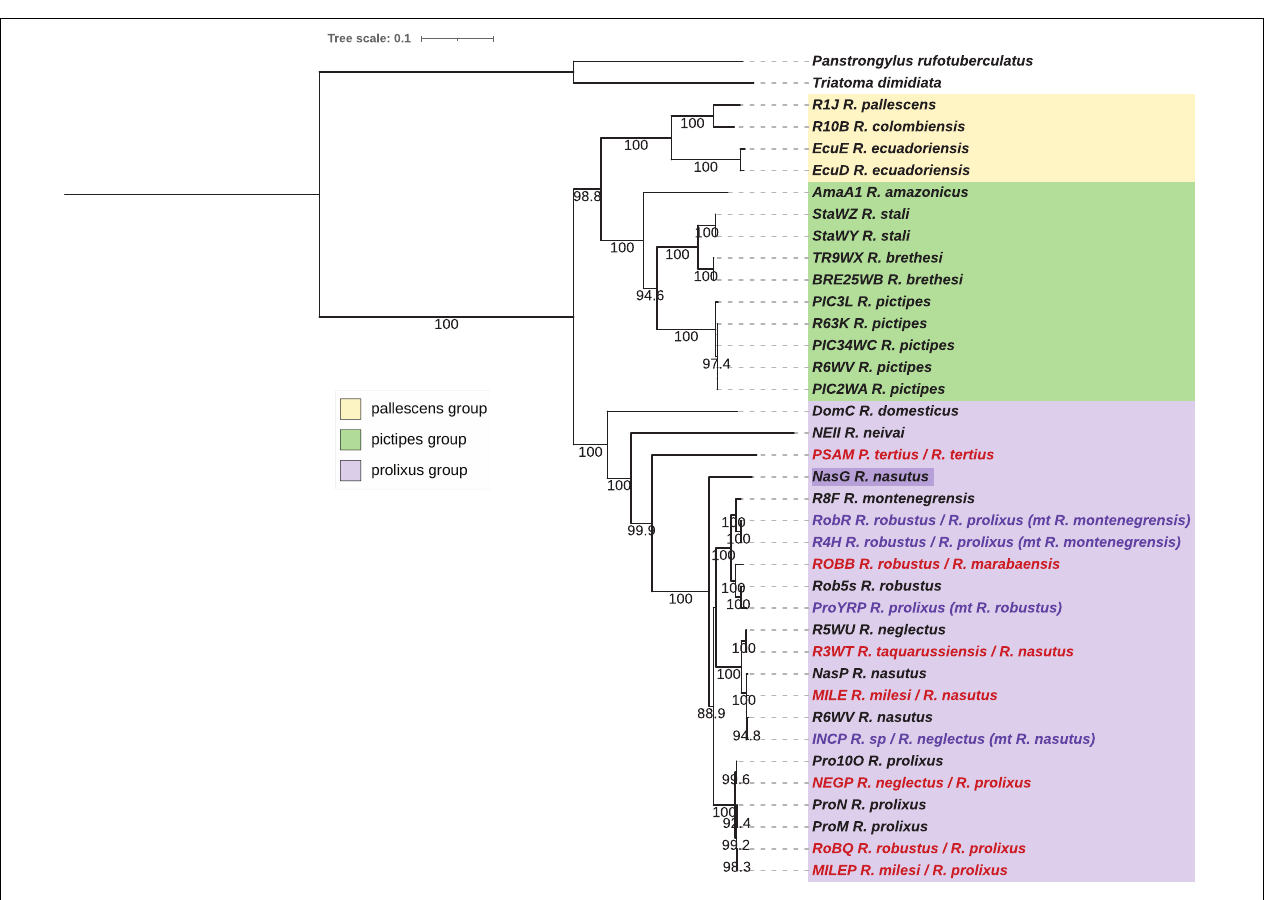
FIGURE 1 | Phylogenetic inferences for the concatenated mitochondrial (mtG) dataset for Rhodnius species with the Maximum Likelihood (ML) method. Statistical supports (1,000 replicates SH-aLRT) are indicated on the nodes. T. dimidiata and P. rufotuberculatus are used as outgroups. Introgressed species inferred from the nuclear phylogeny (see Figure 5 ) are indicated in purple, misidentified species in red, and species with incongruent position are highlighted in dark